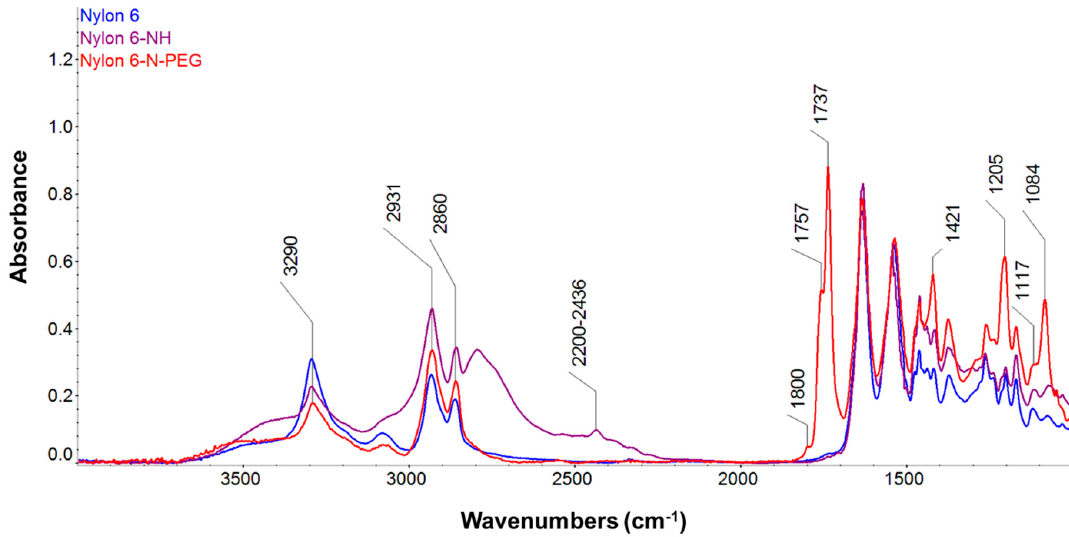
Figure 5. The FTIR spectra comparing pure and modified Nylon 6 samples.